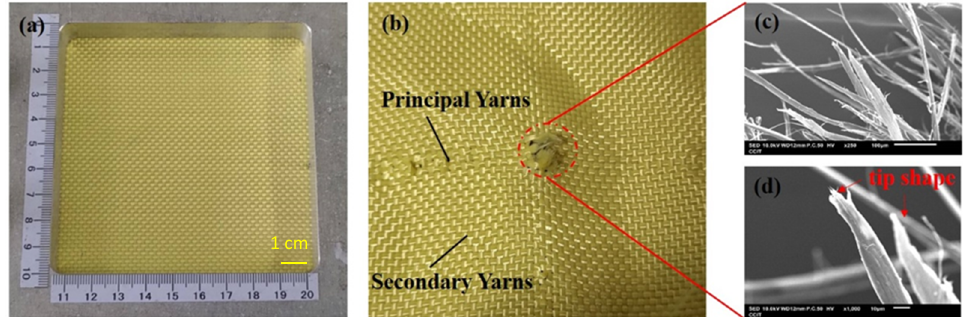
Figure 4. Observation of the single-ply ( a ) neat Kevlar plate before the ballistic test; ( b ) failed fabric with neat Kevlar plate after ballistic test; ( c ) the close-up look of the failed fibers in ( b ); ( d ) the zoomed-in image of the failed fibers in ( c ).